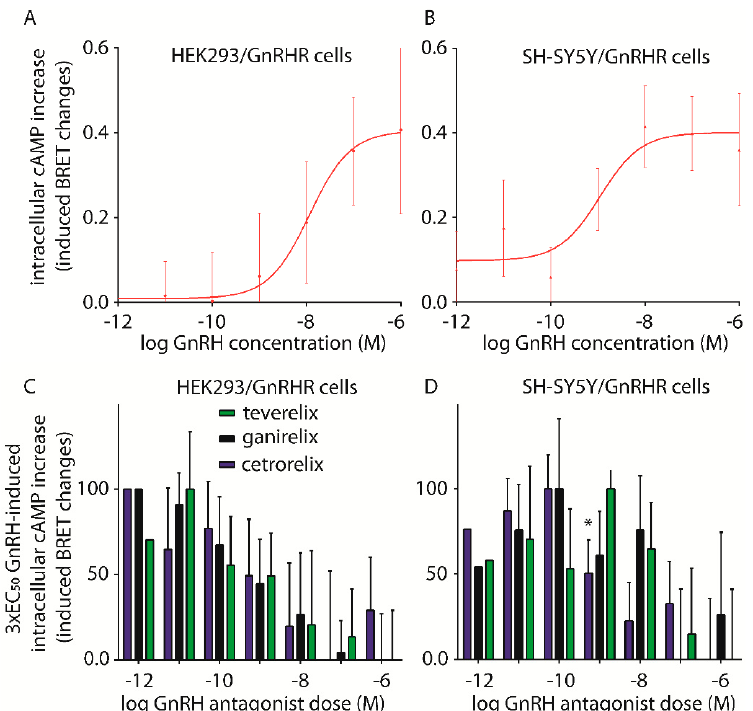
Figure 3. Evaluation of cAMP activation induced by GnRH, in the presence or in the absence of GnRH antagonists. ( A ) HEK293/GnRHR or ( B ) SH-SY5Y/GnRHR cells were maintained for 30 min with